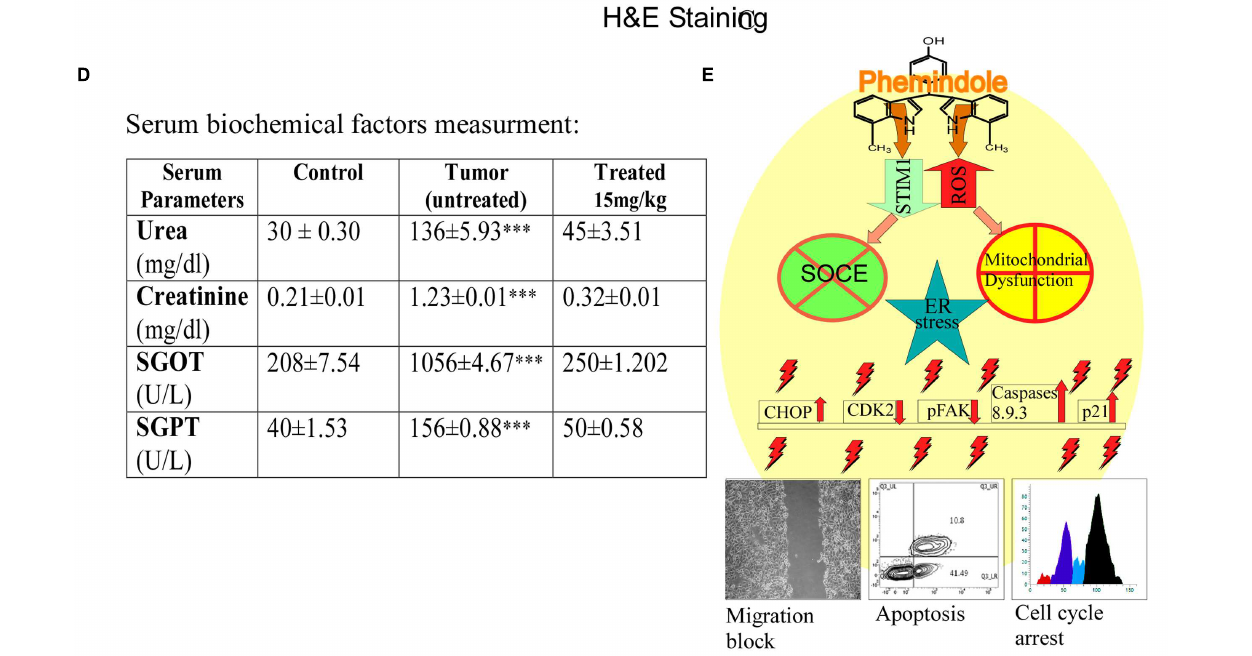
Frontiers in Pharmacology |